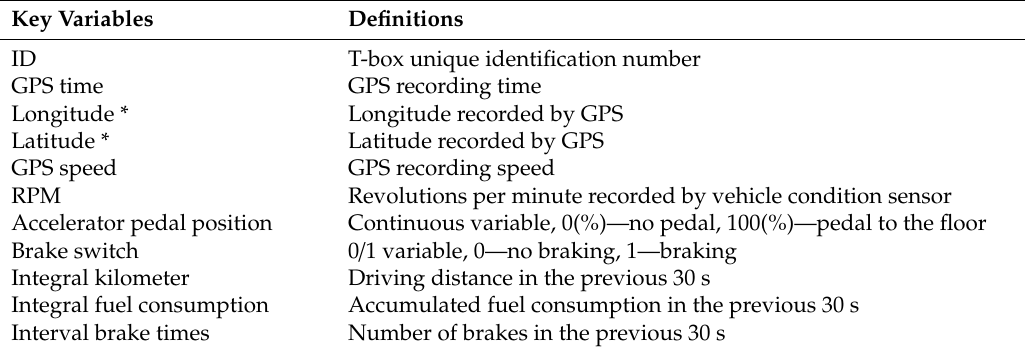
Table 1. Key variables available after data